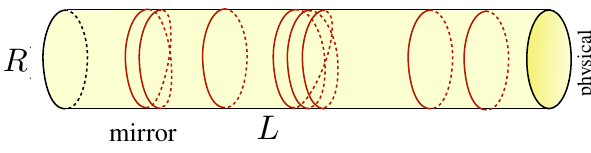
Figure 3 . Virtual particles wrapping the space multiple